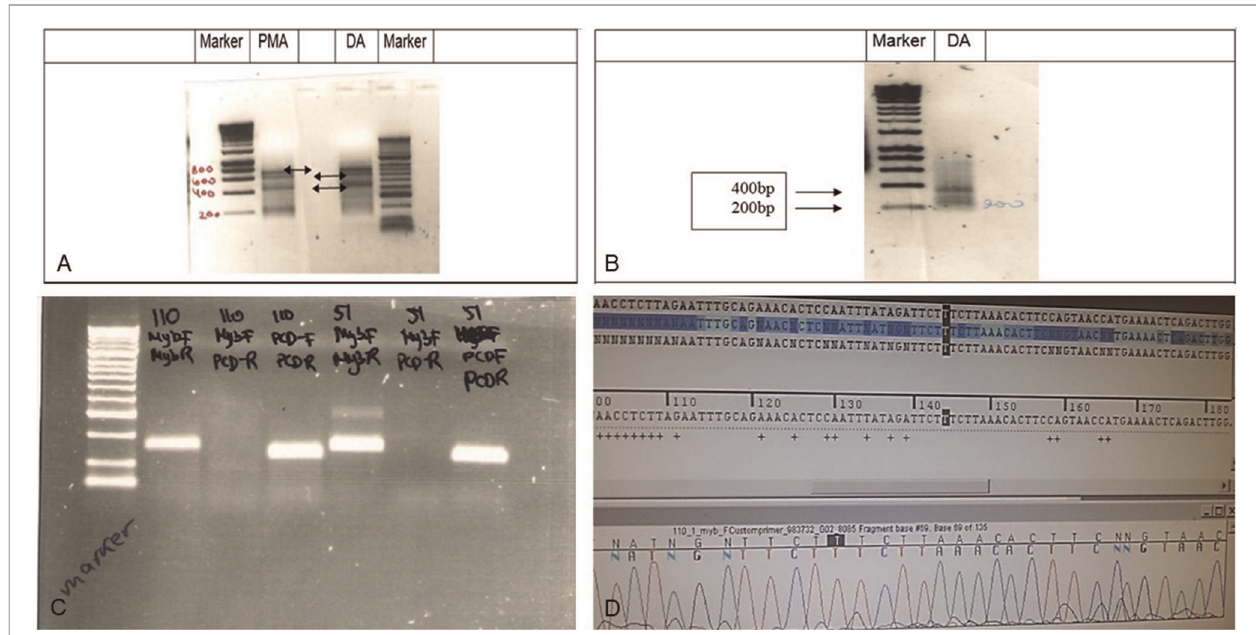
FIGURE 2 | RACE analysis for MYB translocation. ( A ) RACE analysis of Grade II glioma samples 55 (PMA,102) and 51 (DA). RACE gel results showing the bands (amplicons by primers combination 1+3). Note the bands at 700k, 600k and 450k (arrows) in both samples If translocation occurred, then the PCR reaction will give a shorter amplicon. ( B ) RACE results primers 2+3 in sample 51 show 2 bands, 200 and 380 bp. ( C ) PCR products in gel. Left to right: Marker, Sample 53 (110) primer combination of MYB F+R, MYB F+ PCDHGA1 R, PCDHGA1 F+R, sample 51 combination of primers of MYB F+R, MYB F+ PCDHGA1 R, PCDHGA1 F+R. Only 53(110) showed light band in MYB F+ PCDHGA1 R combination, suggesting translocation of the MYB. ( D ) S equence of the normal MYB in sample 55. Validation PCR only showed the normal MYB sequence.